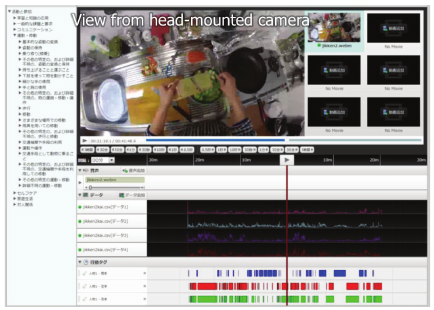
Figure 6: Analysis using video-tagging tool and ICF [12].